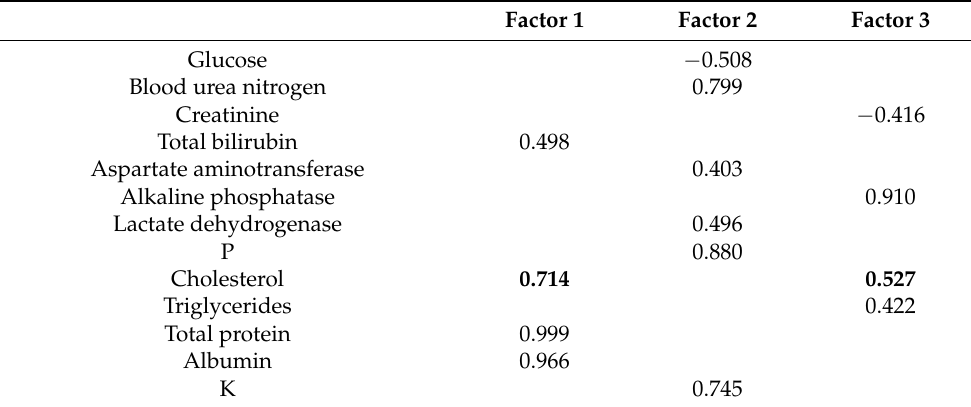
Table 5. Factor loadings (structure matrix) a,b .